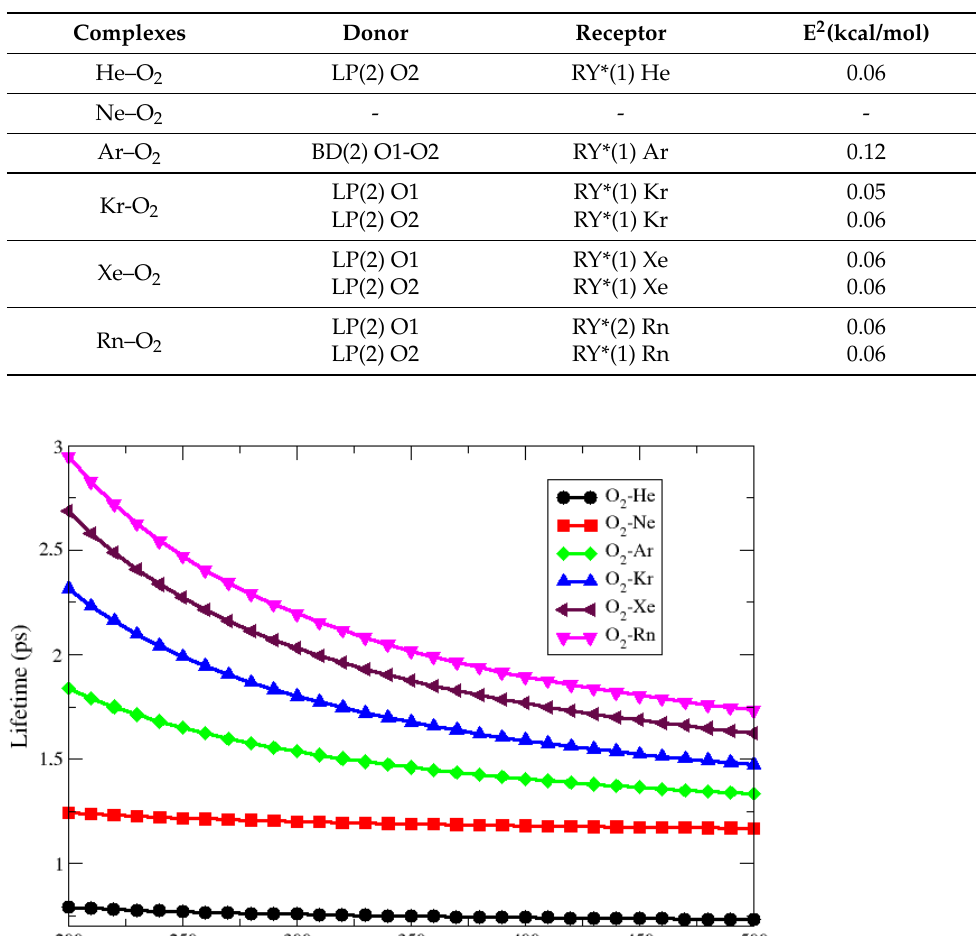
Table 7. Natural bond orbital population analysis obtained through second-order perturbation energies (E 2 ) at the CCSD(T)/aug-cc-pVTZ level for the Ng–O 2 complexes.